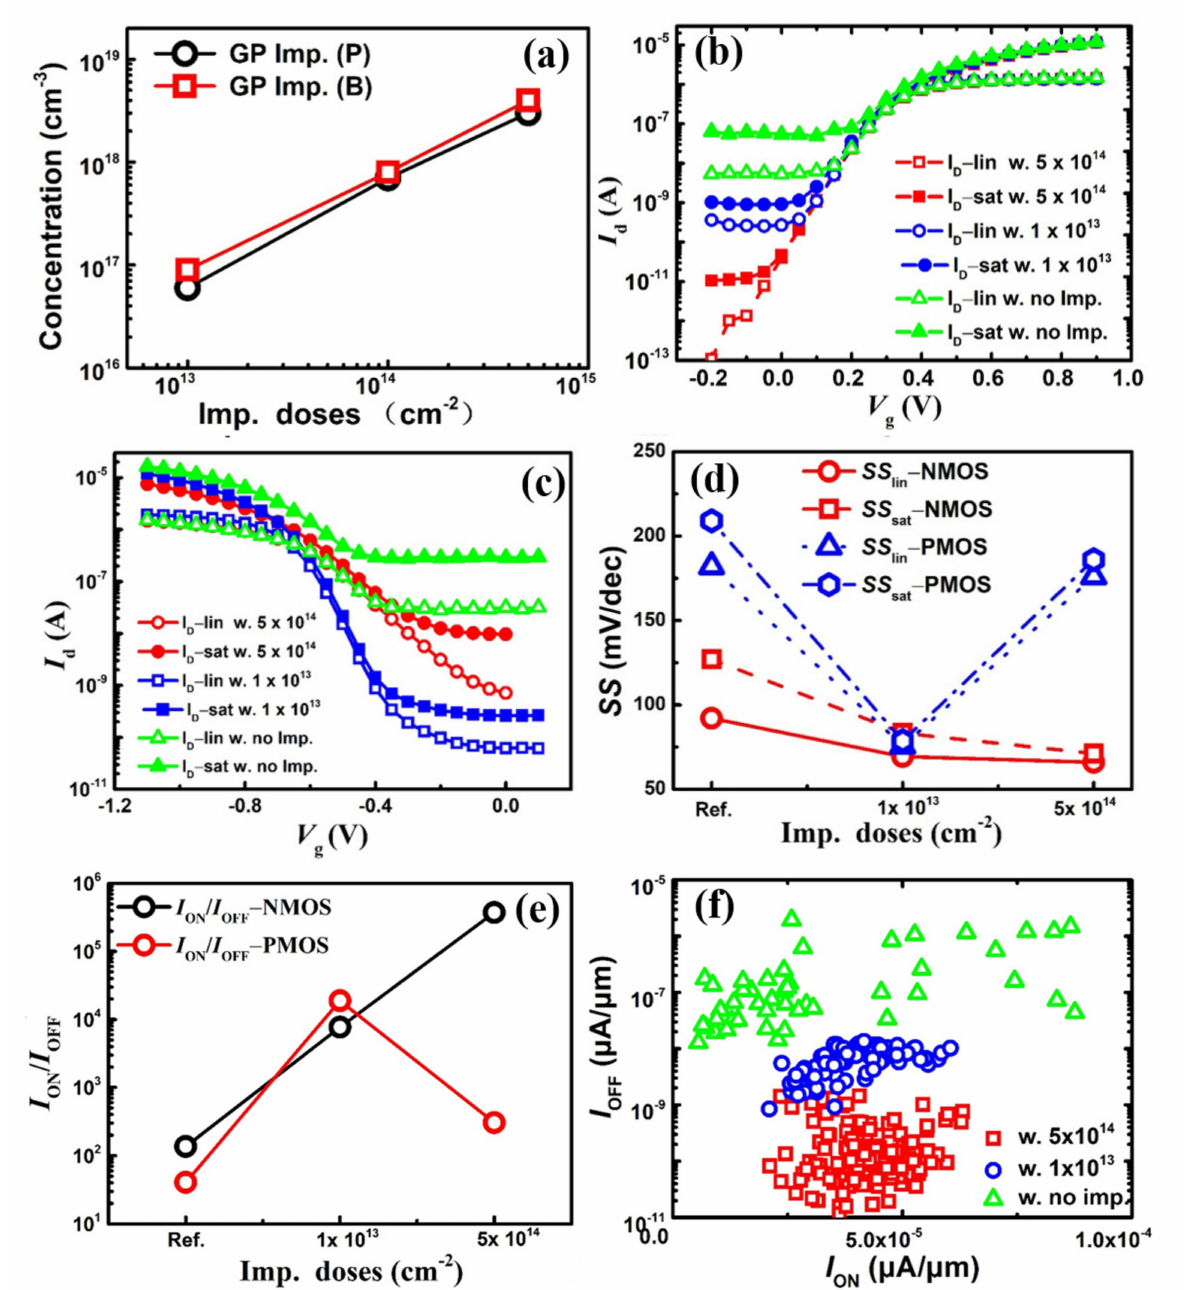
Figure 9. ( a ) Concentration of dopants as a function of doping doses of implant doping doses, ( b , c ) experimental I D - V G of n- / p- type stacked GAA Si NS devices, ( d , e ) I ON / I OFF ratios, SS lin and SS sat extracted with different GP doping conditions, and ( f ) I ON - I OFF mapping of n- type stacked GAA Si NSs